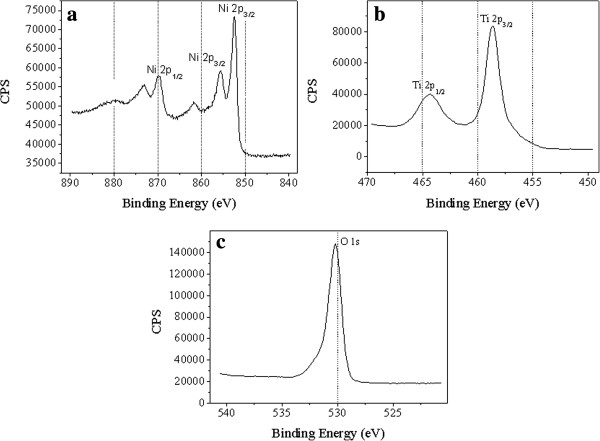
XPS analysis of the Ni-doped nanotubes. (a) Ni 2p spectrum (b) Ti 2p spectrum, and (c) O 1 s spectrum.